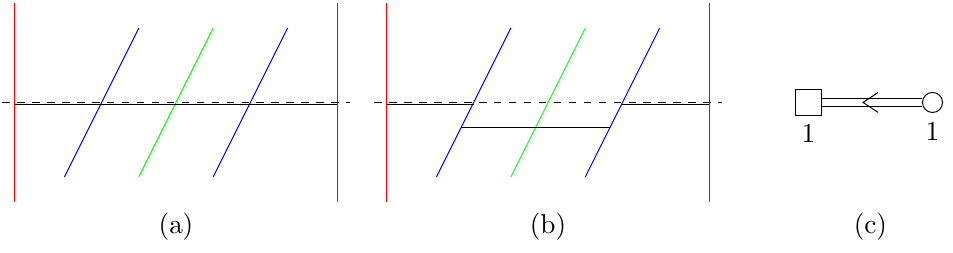
Figure 3 . Brane set up for O (1) with 1 flavour. The green line represents an O 5 + plane. The moduli space of O (1) with 1 flavour consists of only its Higgs branch. The Higgs branch consists of two leaves depicted in the brane constructions (a) and (b). In (c) the magnetic quiver is presented, its Coulomb branch is C 2 / Z